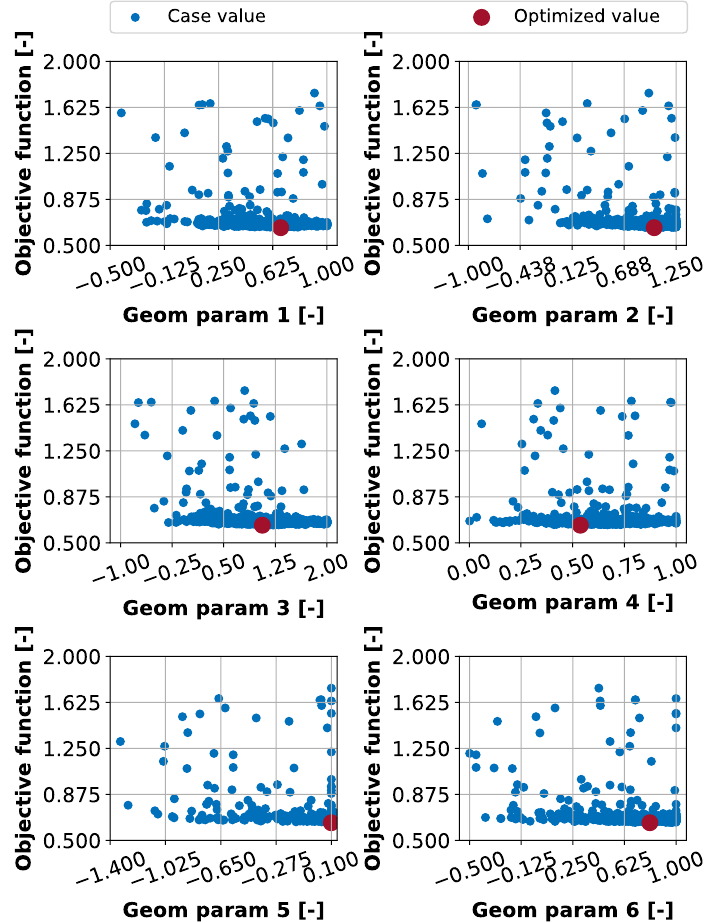
Figure 9. Objective function value for the geometrical